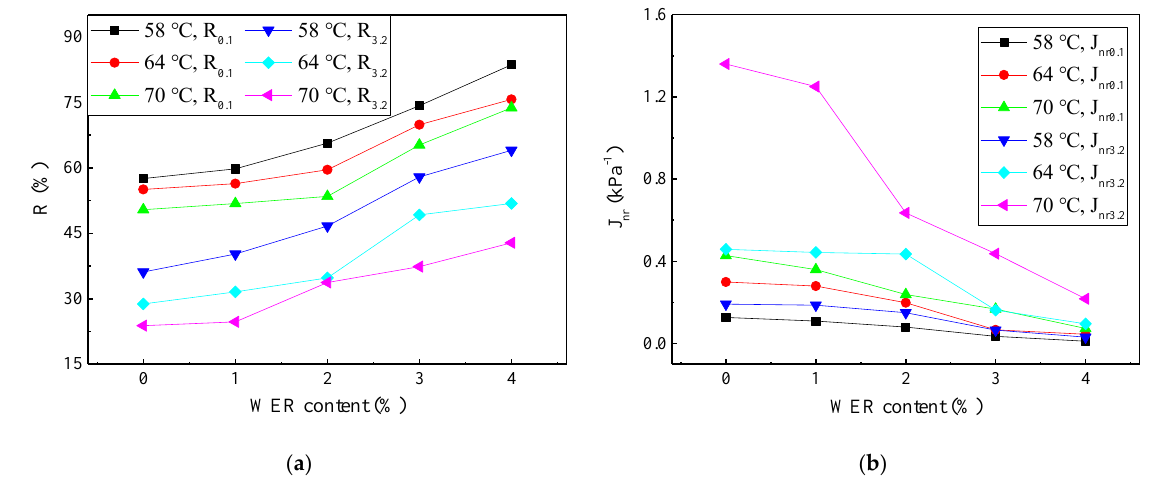
Figure 7. Creep recovery rate R and unrecoverable creep compliance J nr of evaporation residue of the WESAE and the SBRAE: ( a ) changes of R; ( b ) changes of J nr .